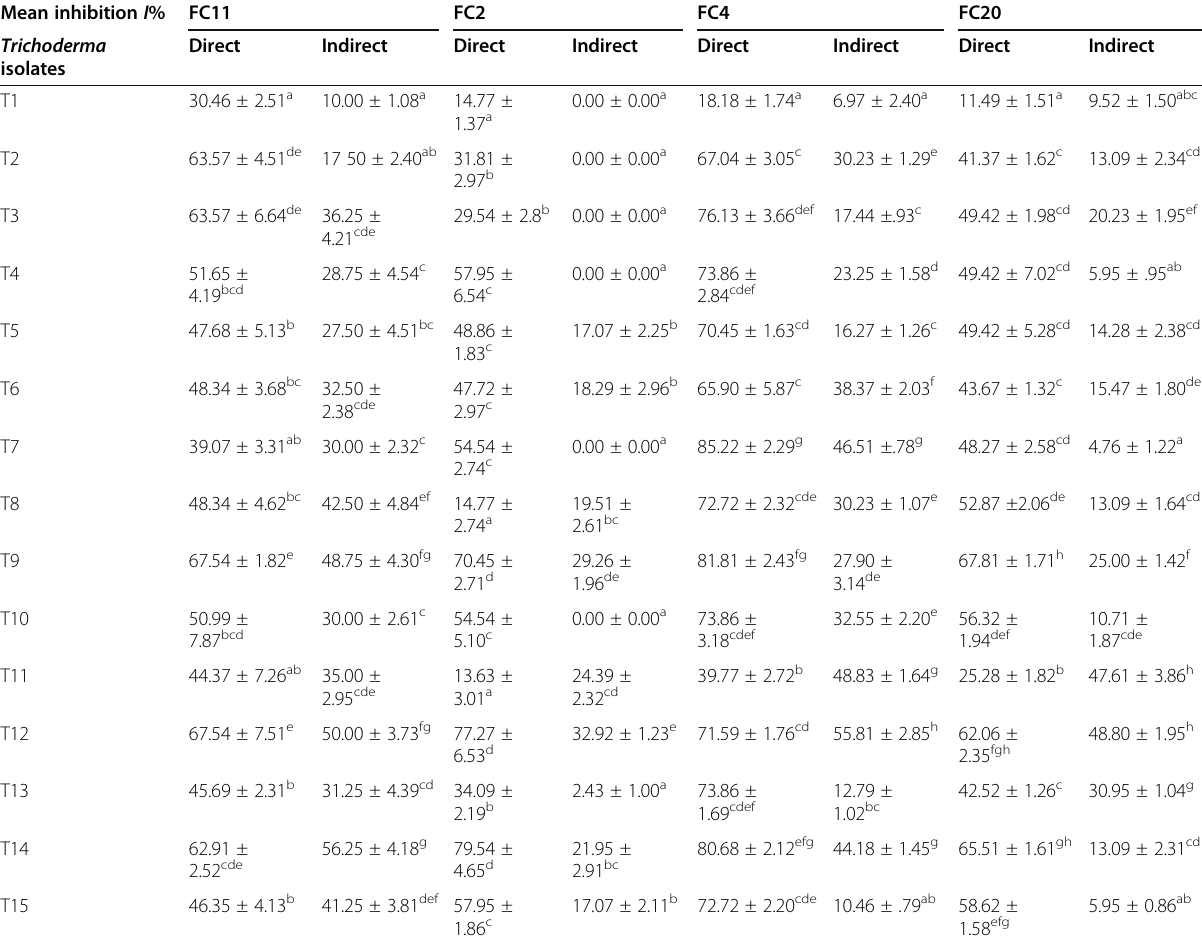
Table 2 The percentage of inhibition of Trichoderma isolates on Fusarium culmorum strains in both cases of confrontation (direct and indirect) after 5 days incubation Mean inhibition I % FC11 FC2 FC4 Trichoderma